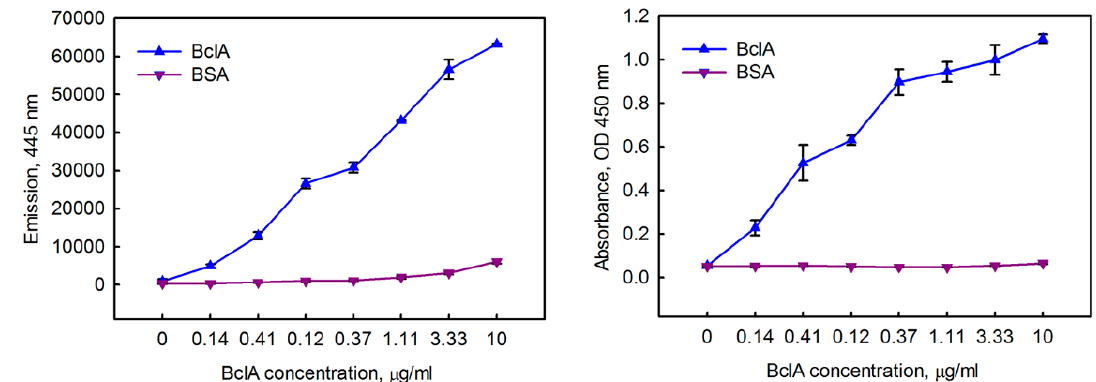
Figure 4. Dose response curves using A5 capture with A5- β -gal tracer ( left ) and A5 capture with Bt-A5 tracer ( right ). Measurements were performed in triplicate; the error bars represent the standard deviation.